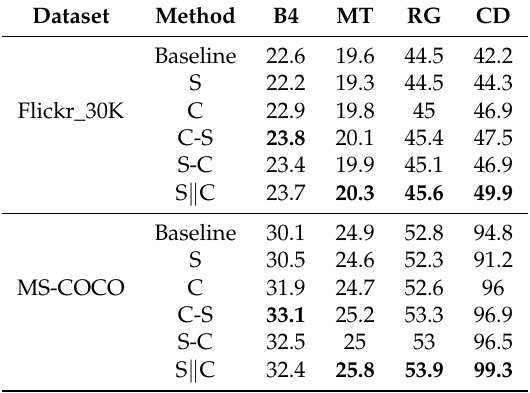
Table 2. The result of different way use attention module in Flickr-30K and MS-coco datasets.